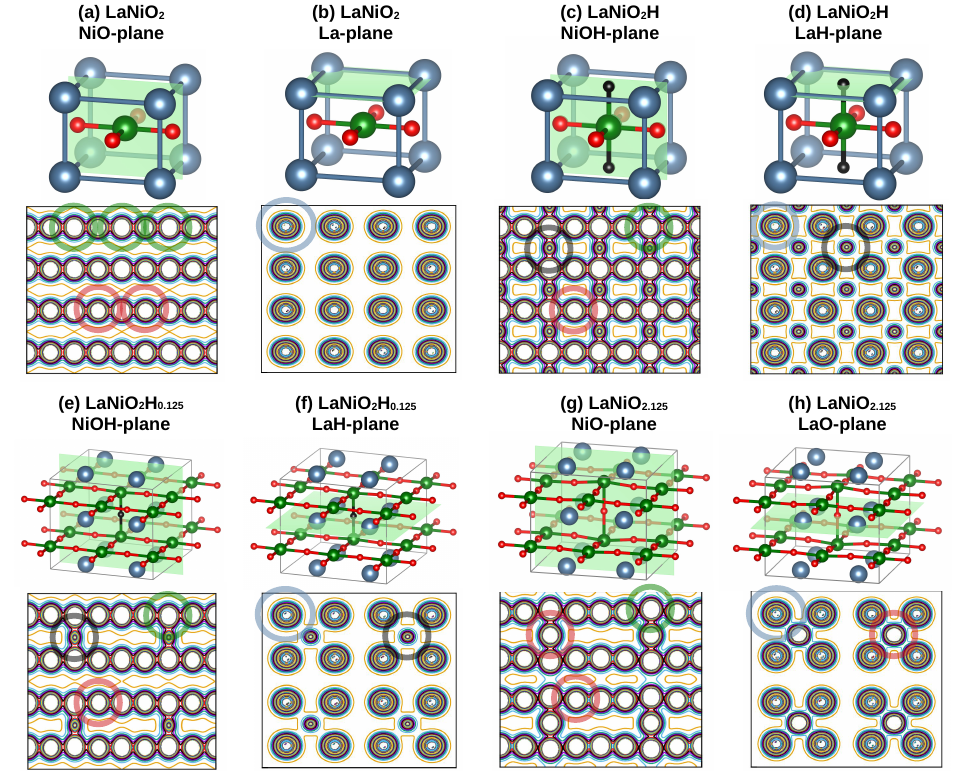
Figure 5. DFT calculated valence charge density of ( a , b ) LaNiO 2 , ( c , d ) LaNiO 2 H, and a LaNiO 2 supercell doped with a single ( e , f ) H and ( g , h ) O atom. For each compound, the charge density of (020) and (001) planes are shown in panels ( a , c , e , g ) and ( b , d , f , h ), respectively. The La, Ni, O, and H atoms are labeled by blue, green, red, and black circles,